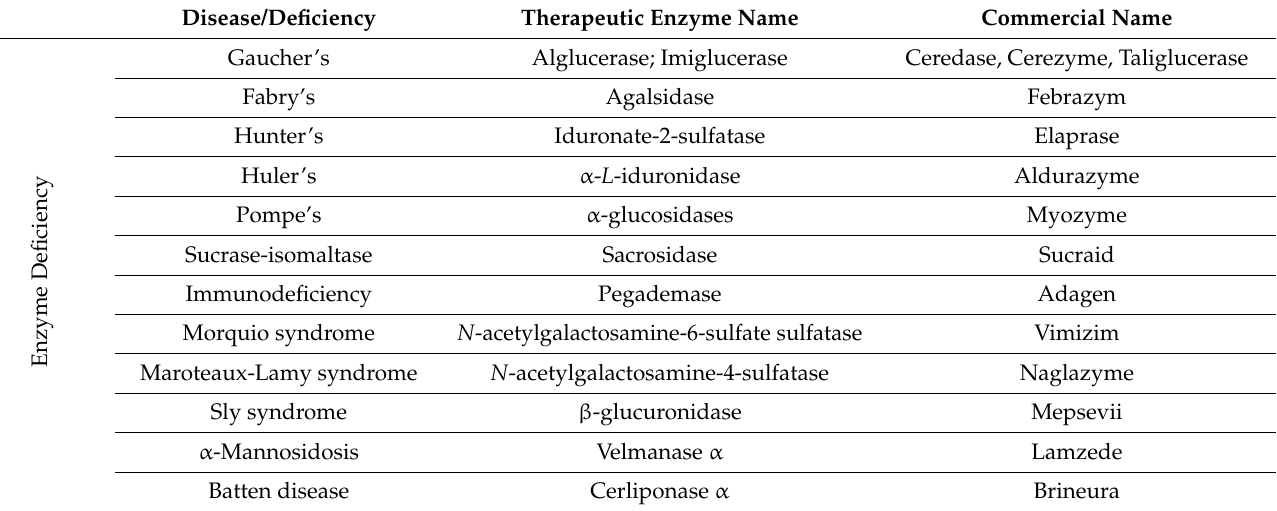
Table 2. Commercialized enzyme-based drugs. Adapted from selected revision articles